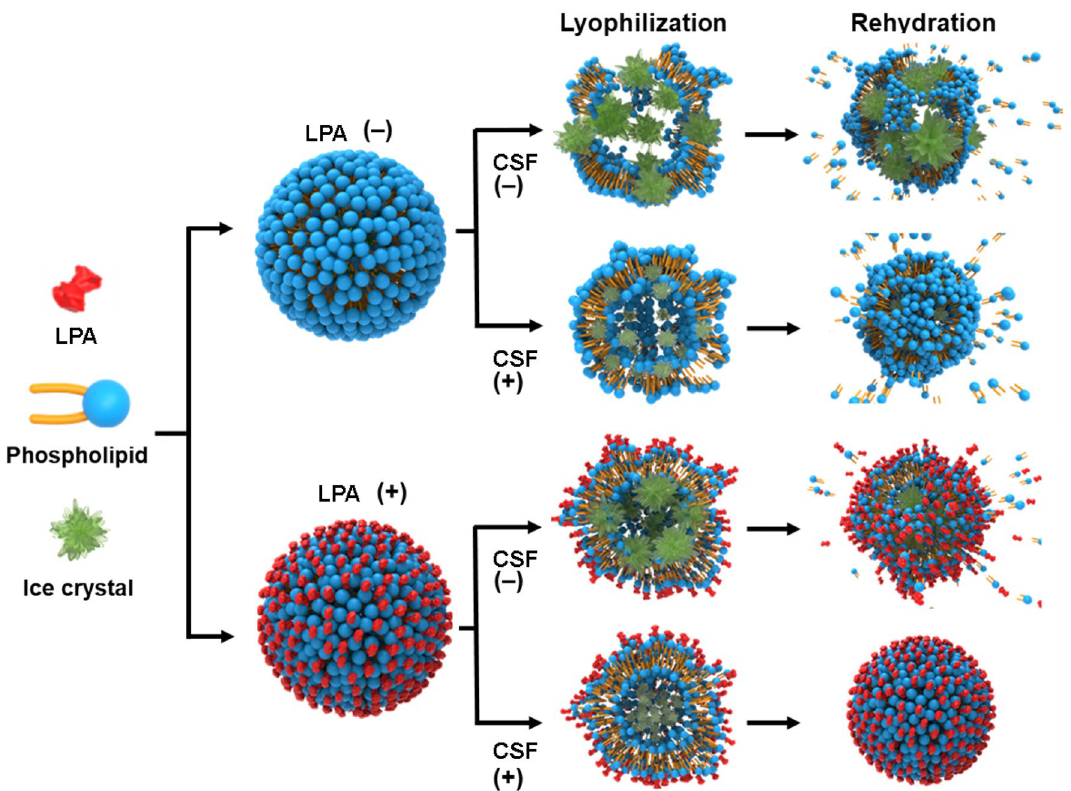
Figure 5. Schematic illustration representing the effects of LPA and CSF on lipid bilayer membranes during lyophilization and